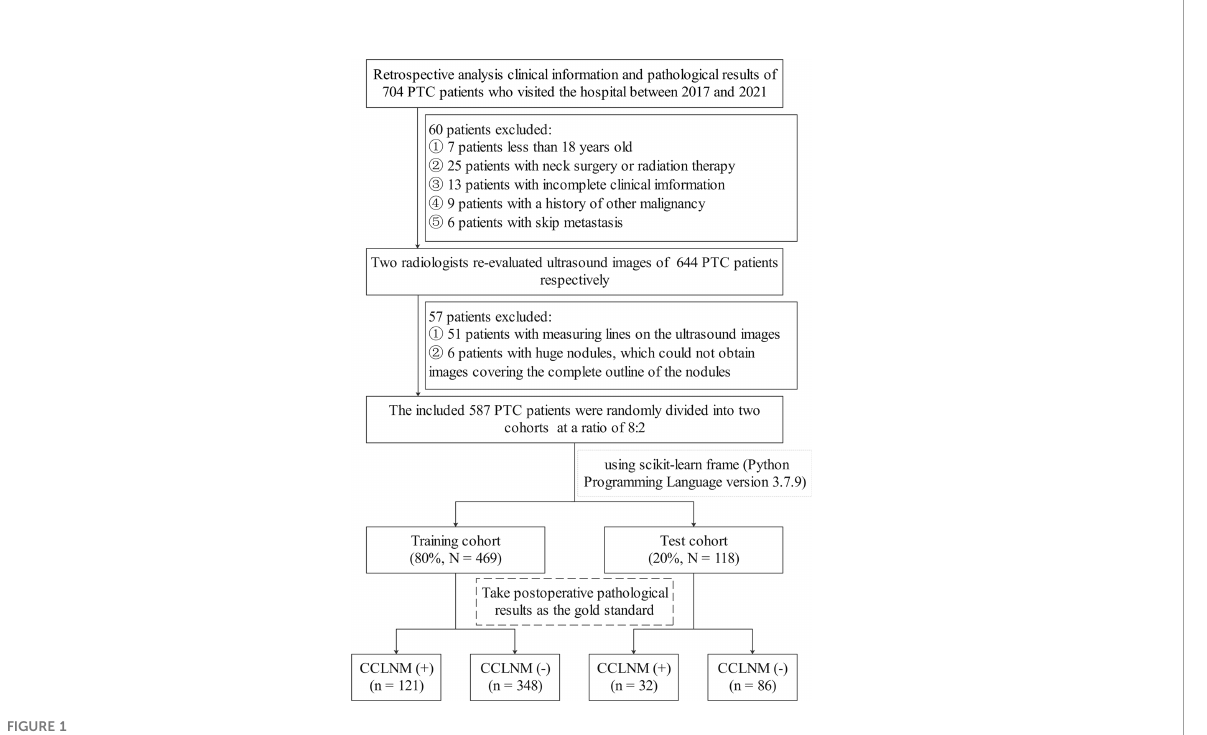
FIGURE 1 Flowchart of patient selection and group allocation for the